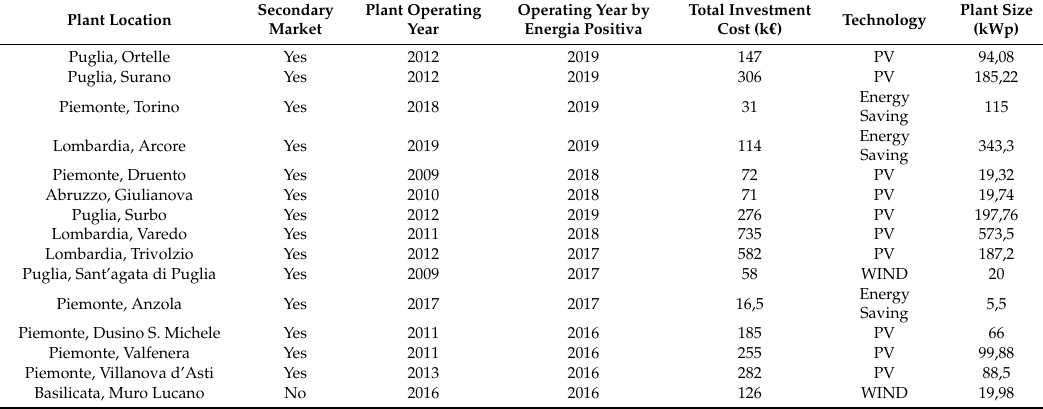
Table 6. Projects developed by Energia